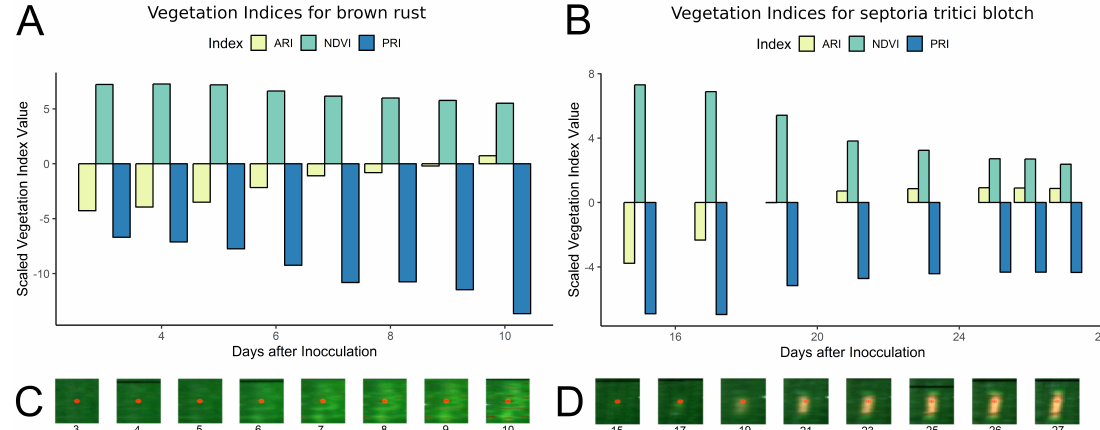
Figure 5. Visualization of the tracing results by using RGB visualizations of a symptom and the corresponding Vegetation indices anthocyanin reflectance index (ARI), normalized difference vegetation index (NDVI), and photochemical reflectance index (PRI) for brown rust ( A , C ) and septoria tritici blotch ( B , D ). For visualization purposes the NDVI was multiplied by 10 and the PRI by 40. Timeseries of spectral characteristics are derived to uncover the deviating spectral dynamics of the diseases.